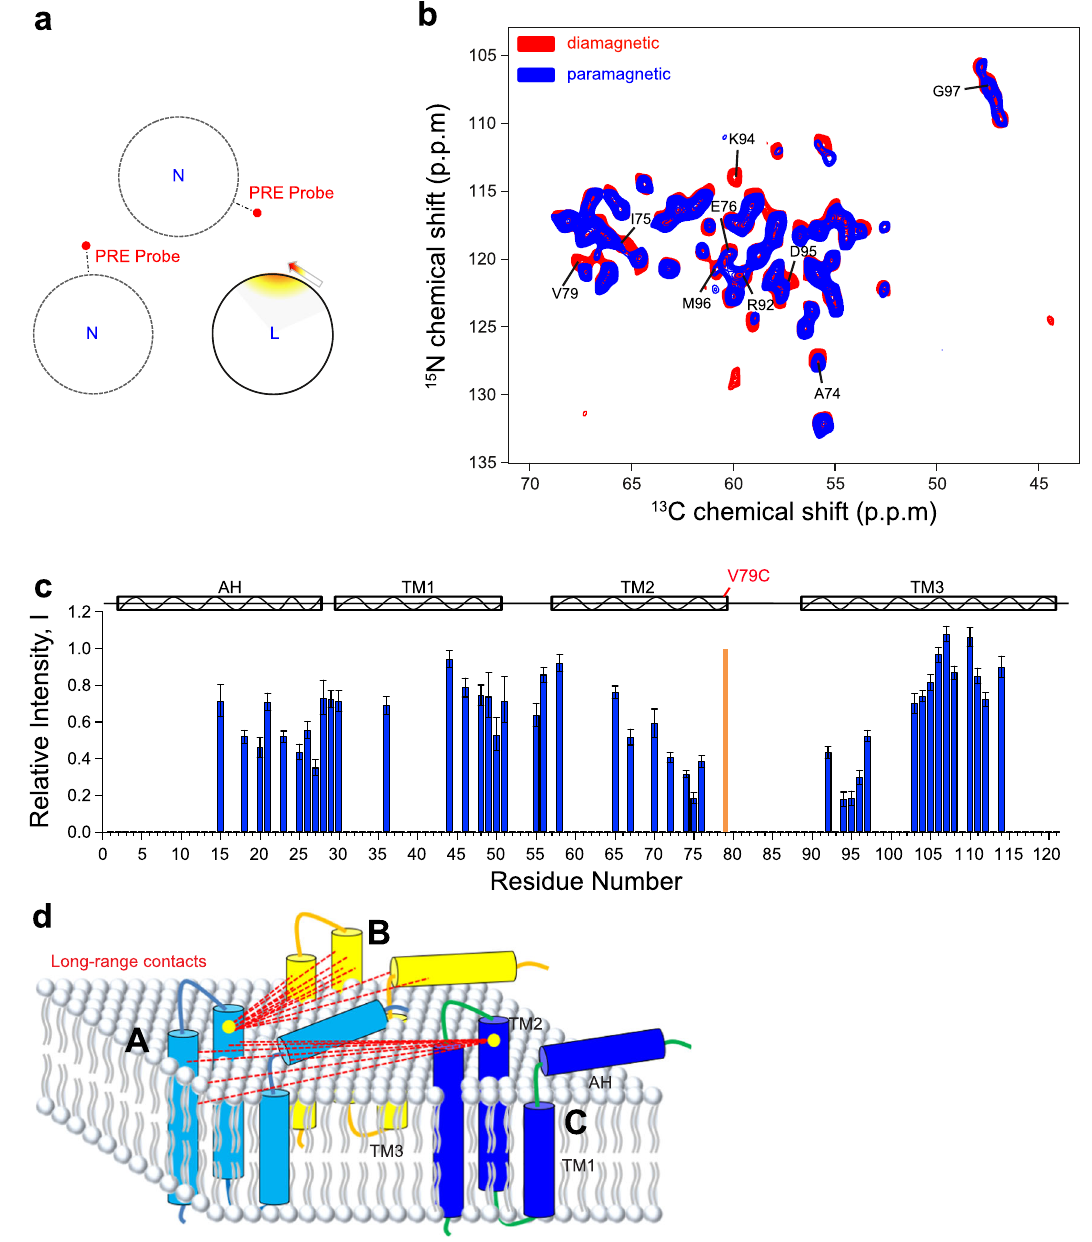
Fig. 4 Extraction of inter-monomer distance restraints from PRE measurements. a Labeling method for acquiring inter-monomer PREs (see Fig. S12 for more details). “ L ” and “ N ” represent uniformly 13 C, 15 N-labeled and natural abundance monomers, respectively. b Superimposition of the 2D NCA spectrum of the paramagnetic sample, na-MTSL-V79C-DgkA/ 13 C, 15 N-C46A-C113A-DgkA (blue), on that of the diamagnetic cysteine-free sample, 13 C, 15 N-C46A- C113A-DgkA (red). The peaks with a large attenuation are labeled. c Inter-monomer PRE contacts observed for DgkA with a spin-label at the site V79C. The relative intensity I (given by Eq. 1), calculated from the height of cross-peaks in the NCA spectra b of paramagnetic and diamagnetic samples, is plotted for each residue with an observed PRE effect. The noise levels of the corresponding peaks were shown by error bars. The secondary structure of DgkA is shown on the top, with the spin-labeling site of V79C highlighted in orange. d Inter-monomer long-range (|i-j| > 5) electron – nuclear distances (dashed lines) obtained from PREs measured in the DgkA mutants with a spin-label introduced at the residue V79C (yellow